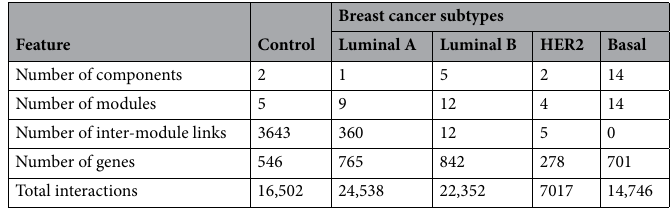
Table 2. Structural features of the top100,000 GCNs k-cores .